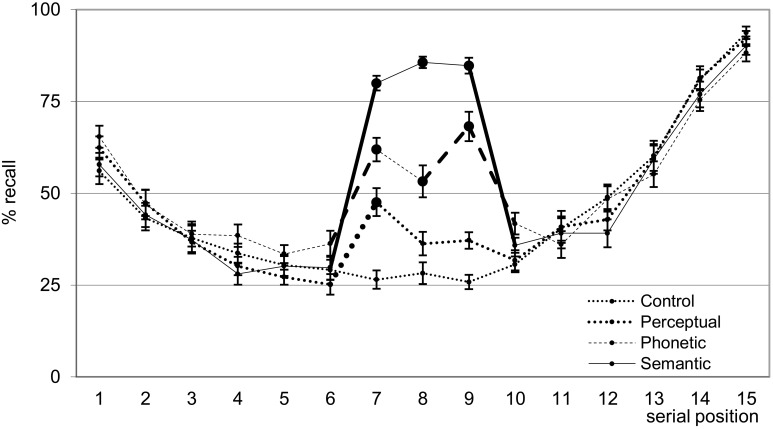
Mean (±SE) of the percentage of words freely recalled according to serial position for the four list types. Bold lines indicate difference between adjacent serial positions; large filled circles () indicate difference from control lists. Bold segments indicate within list differences. See text for detailed statistical results.